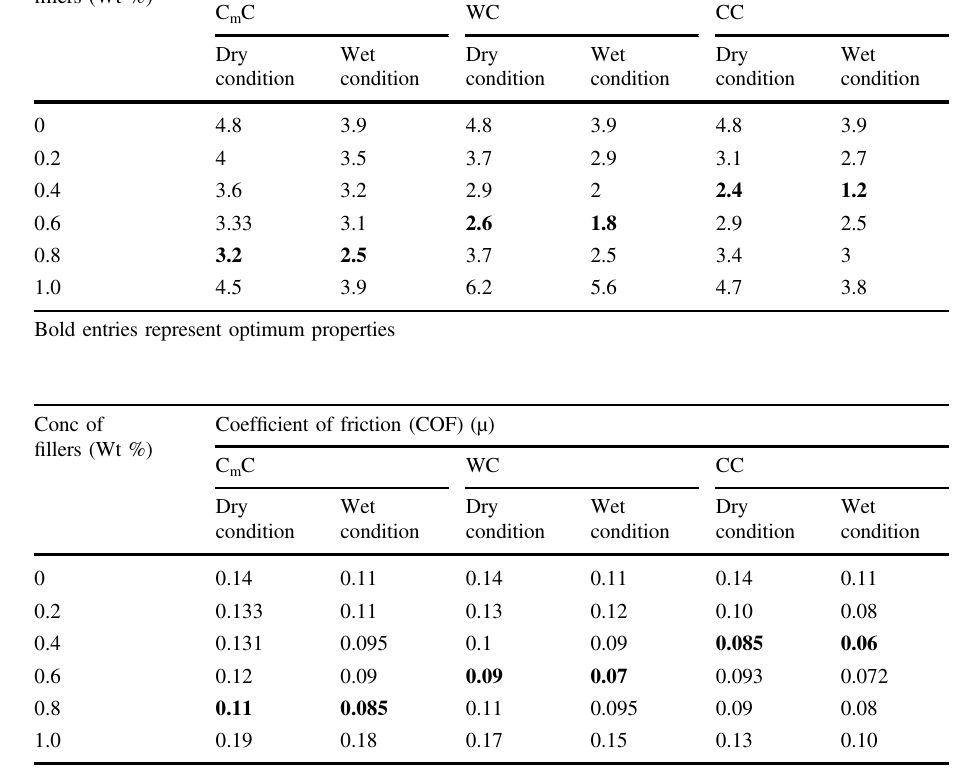
Table 5 Wear rate of C m C, WC, and CC during wear experiment conducted at 8 N applied load and 300 m sliding distance at room temperature in dry and wet condition